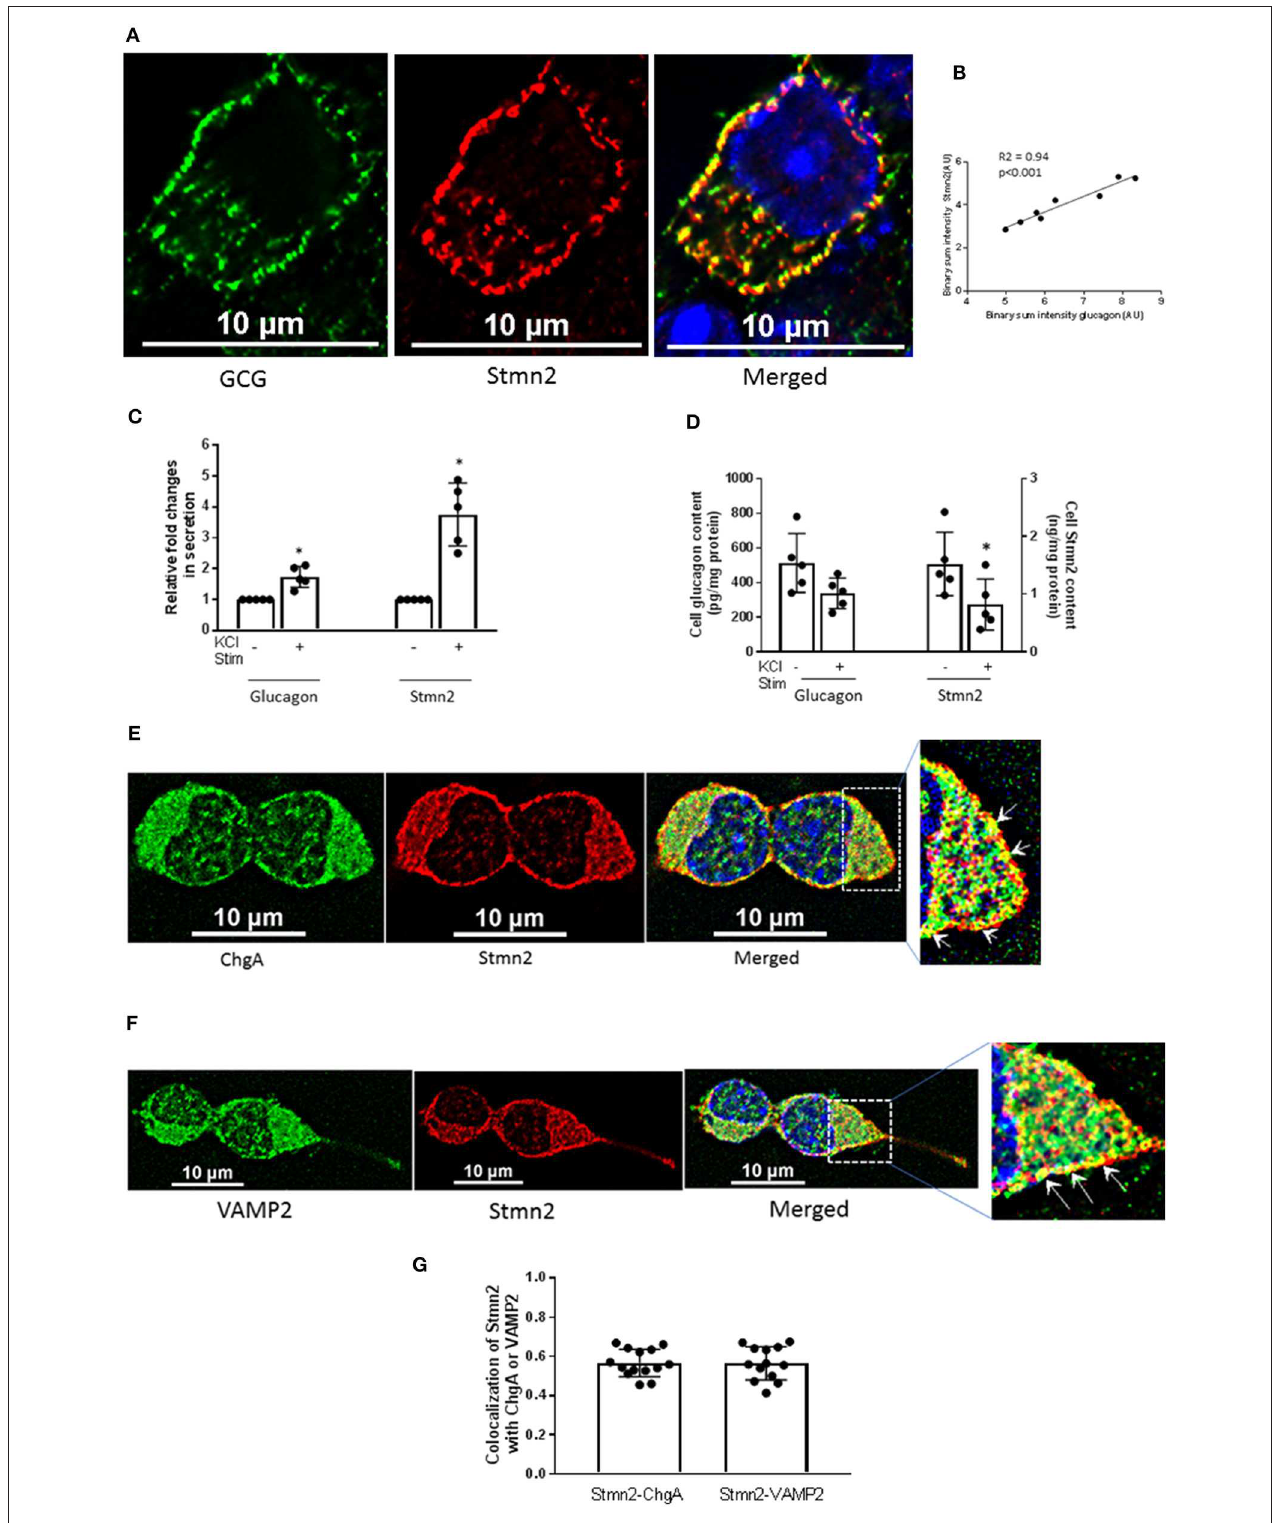
FIGURE 1 | Stathmin-2 localizes to secretory granules in α TC1-6 cells. α TC1-6 cells were immunostained using primary antibodies against glucagon (GCG, green) and stathmin-2 (Stmn2, red). DAPI (blue) indicates the nucleus in the merged image. Resolution of the images was extended by applying Nyquist XY scan and then